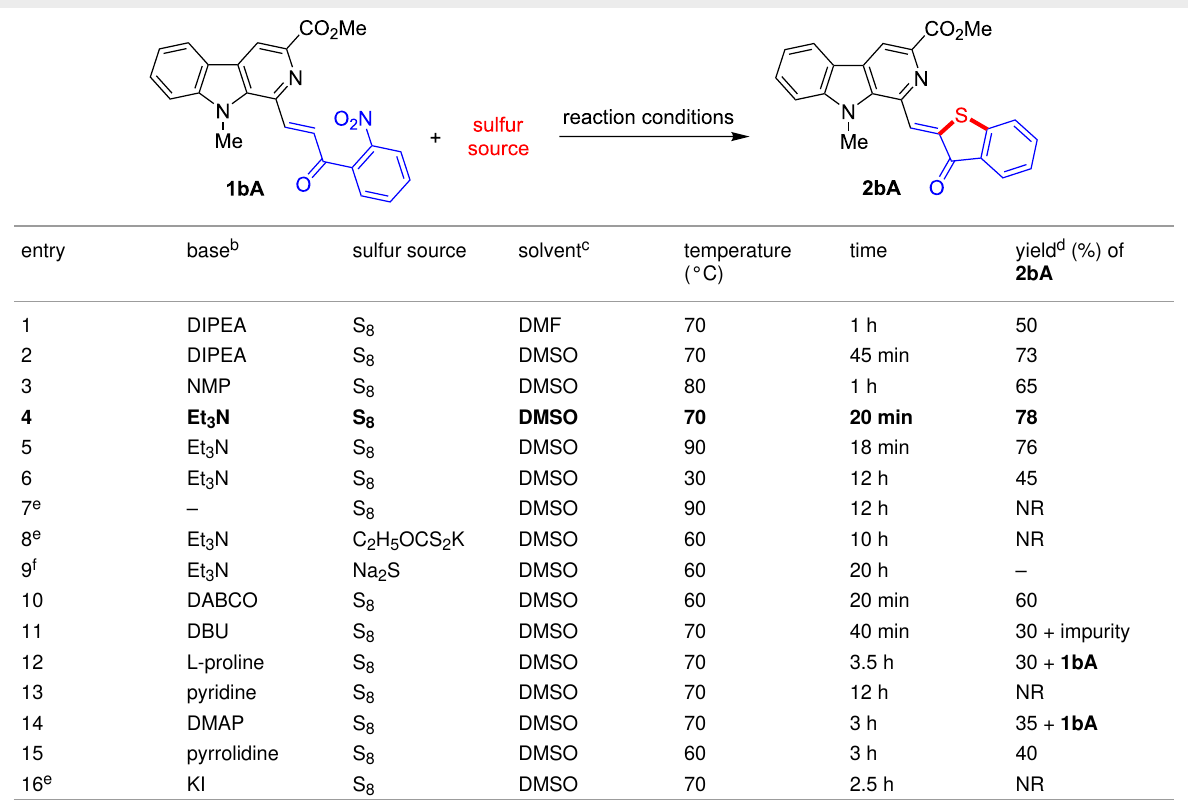
Table 1: Optimization of the reaction conditions. a